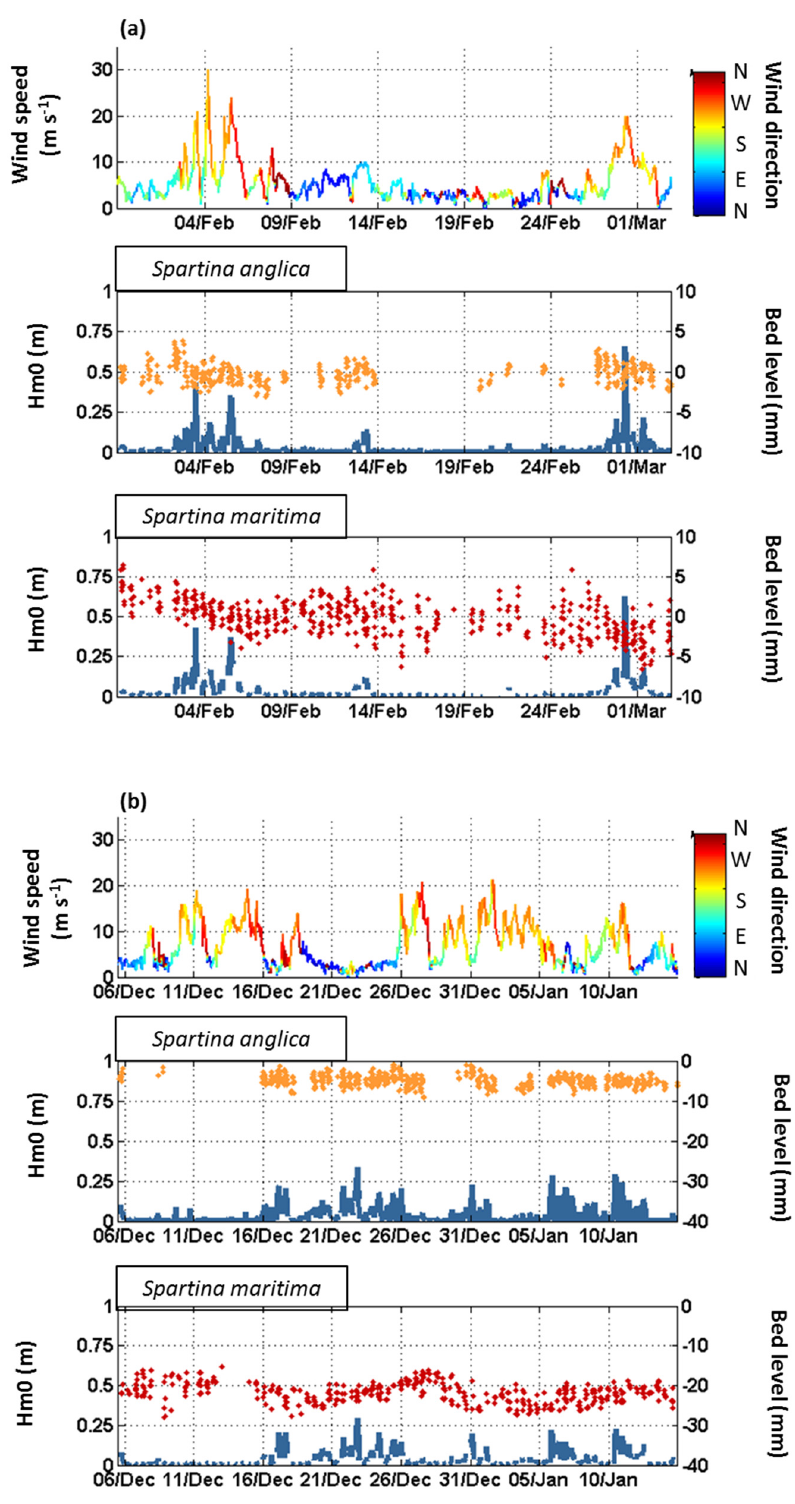
Figure 5. Zoom on winter storm events from ( a ) autumn/winter 2016 and ( b ) autumn/winter 2017. Top graphics consider wind conditions measured at Cap Ferret’s meteorological station with wind speed (line representation) and wind direction (color representation). Central graphics represent measured mean wave height (blue line) and bed level variation (yellow dots) under the influence of Spartina anglica . Bottom graphics represent measured mean wave height (blue line) and bed level variation (red dots) under the influence of Spartina maritima